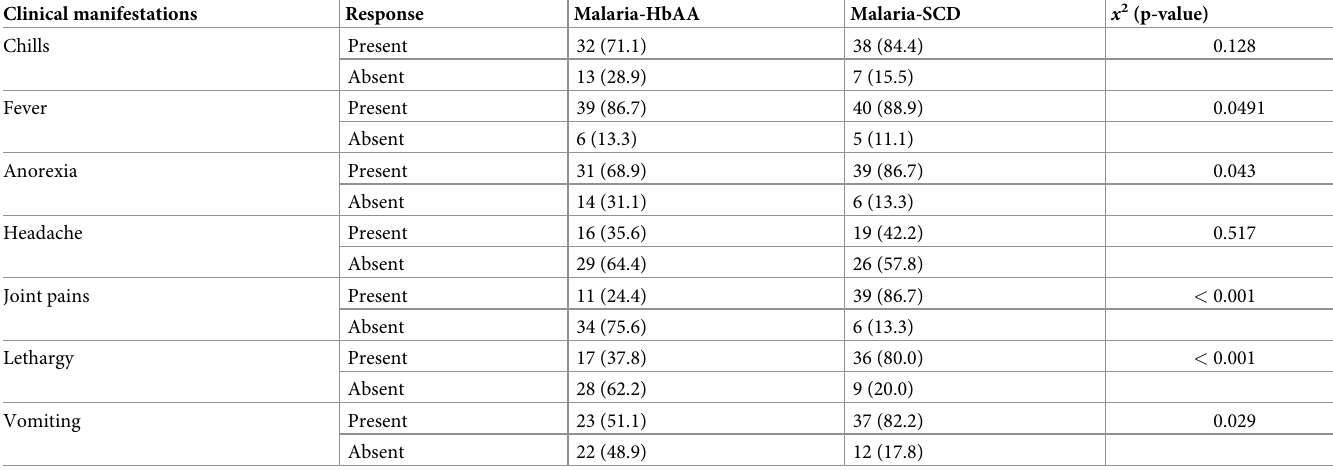
Table 3. Clinical history of the